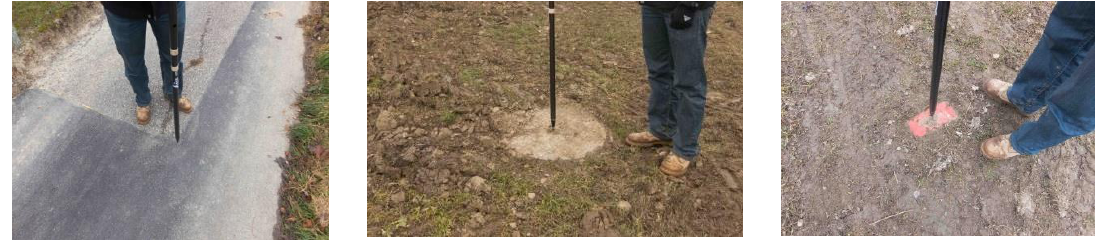
Figure 5. Examples of GCP (artificial and